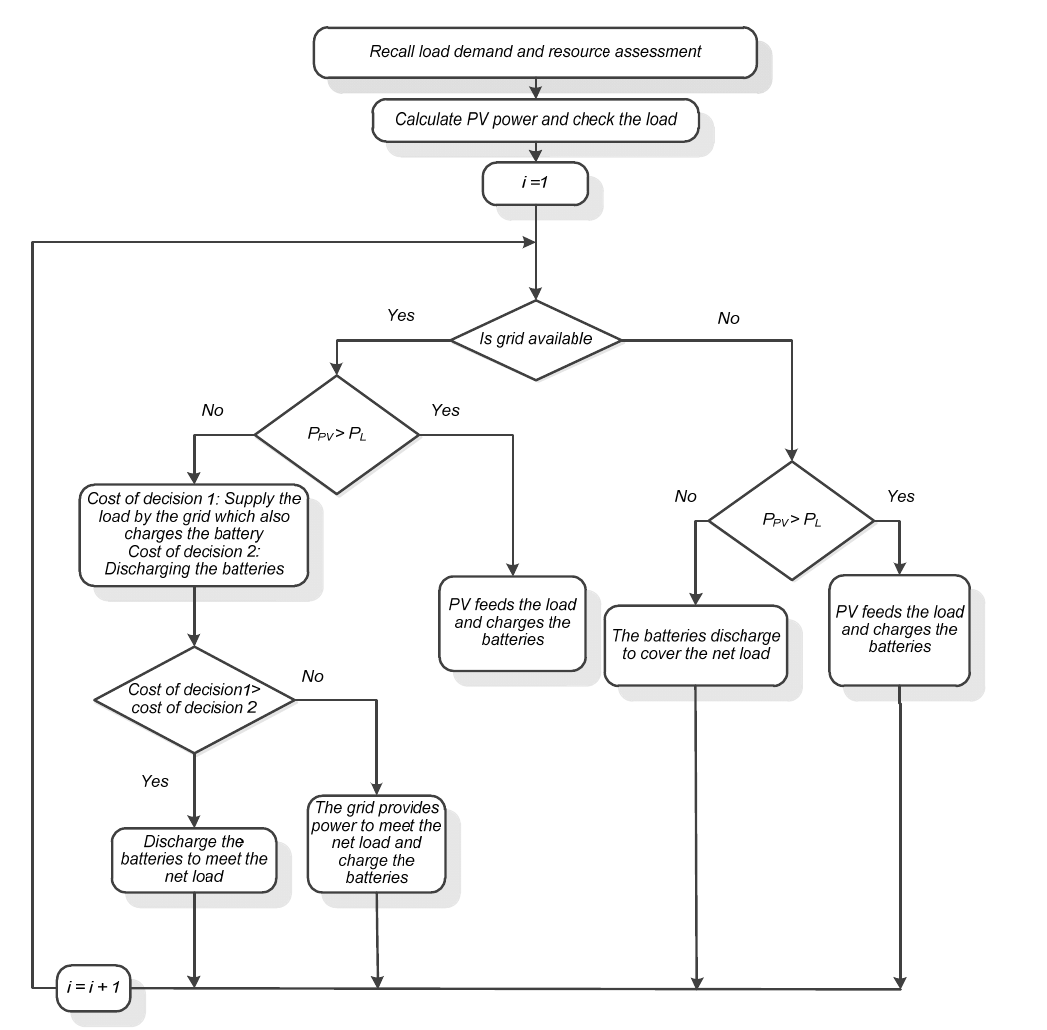
Figure 9. CC strategy for grid-connected PV/battery system.